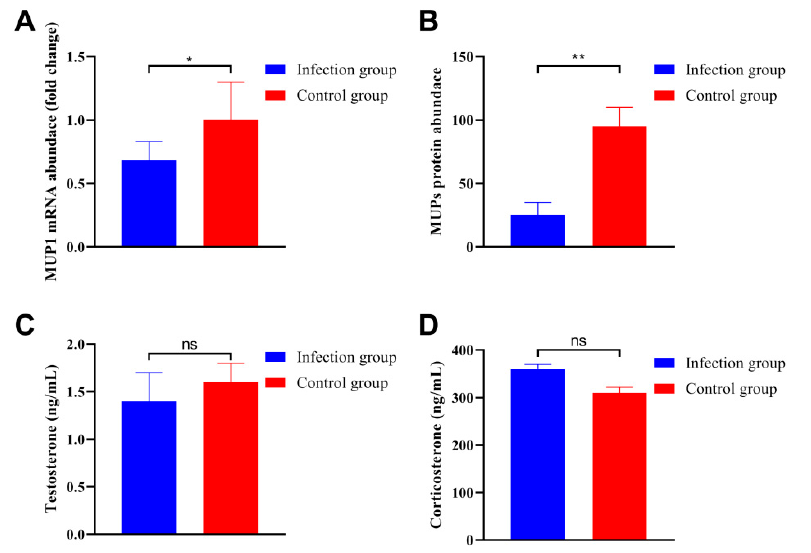
Figure 4. C. parvum infection reduced the expression of MUP variants and showed no influence on the hormone level. ( A ) The expression level of MUP variants in the liver tissue was significantly down-regulated after parasitic infection. ( B ) SDS-PAGE analysis indicated that the protein expression level of MUP was significantly decreased for the mice infected with C. parvum . The levels of testosterone ( C ) and corticosterone ( D ) in serum showed no significant differences between the infection group and control group. All data are presented as means ± standard deviation. Two-way ANOVA was used for significance analysis, and all statistical analyses were performed with GraphPad Prism 8. * p < 0.1; ** p < 0.01; ns